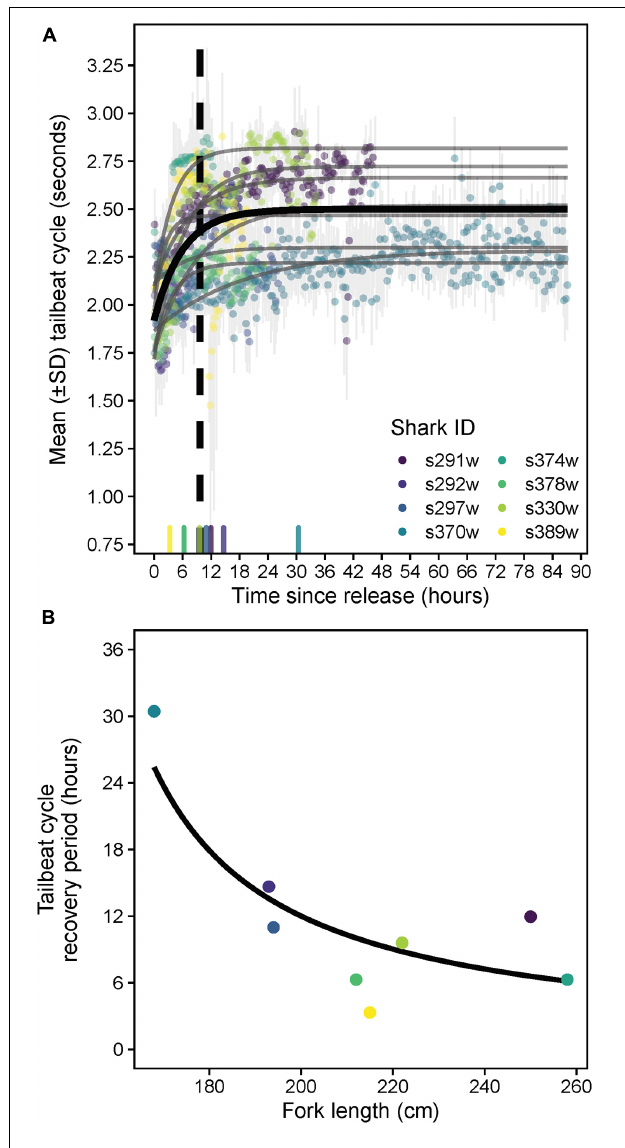
FIGURE 5 | (A) Predicted population- (black) and individual-level (gray) asymptotic relationships between mean tailbeat cycle length and time since release for white sharks released from SMART drumlines. The X -axis rug plot shows recovery periods (time at 80% of the difference between initial and asymptotic tailbeat cycle values) for individual sharks, with the dashed vertical line indicating the population-level recovery period. Note recovery times for sharks s374w and s378w were similar and thus overlap on the rug plot. (B) Predicted relationship between fork length and the tailbeat cycle-derived recovery periods of sharks from a gamma generalized linear